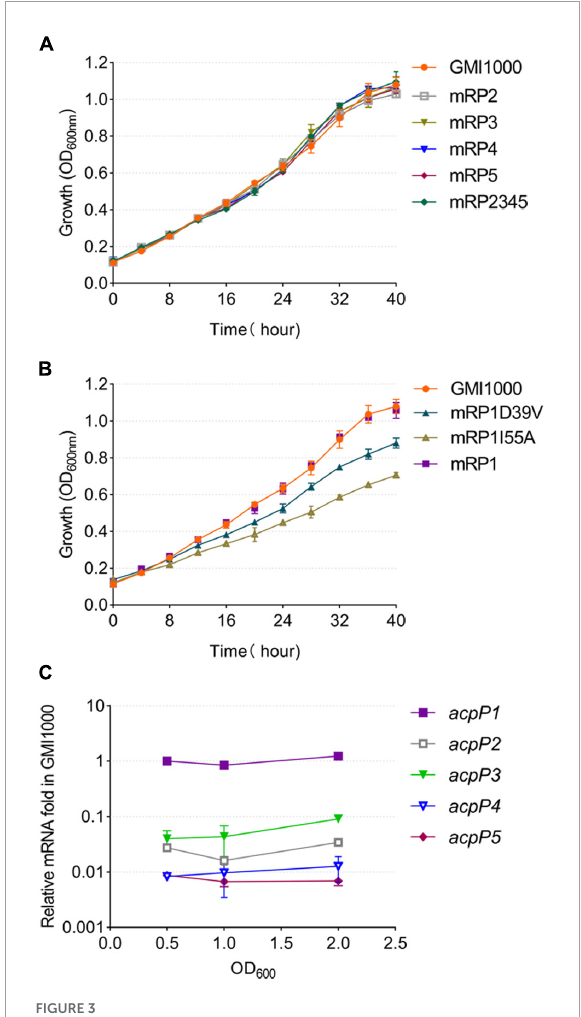
FIGURE3 Only the AcpP1 affects the growth of R . solanacearum . (A,B) Growth of the strains in BG medium at 30 ◦ C. GMI1000, wild-type strain; mRP1D39V, mutant in which Asp39 of AcpP1 is altered to Val; mRP1I55A, mutant in which Ile55 of AcpP1 is altered to Ala; mRP1, mutant in which the acpP1 gene is replaced with E. coli acpP ; mRP2, mutant lacking acpP2 gene; mRP3, mutant lacking acpP3 gene; mRP4, mutant lacking acpP4 gene; mRP5, mutant lacking acpP5 gene; mRP2345, mutant lacking acpP2 , acpP3 , acpP4 , and acpP5 genes. (C) Expression of the five acp genes in R . solanacearum wild-type strain GMI1000. Expression level of the acpP1 gene in log phase (OD 600 = 0.5) was set to